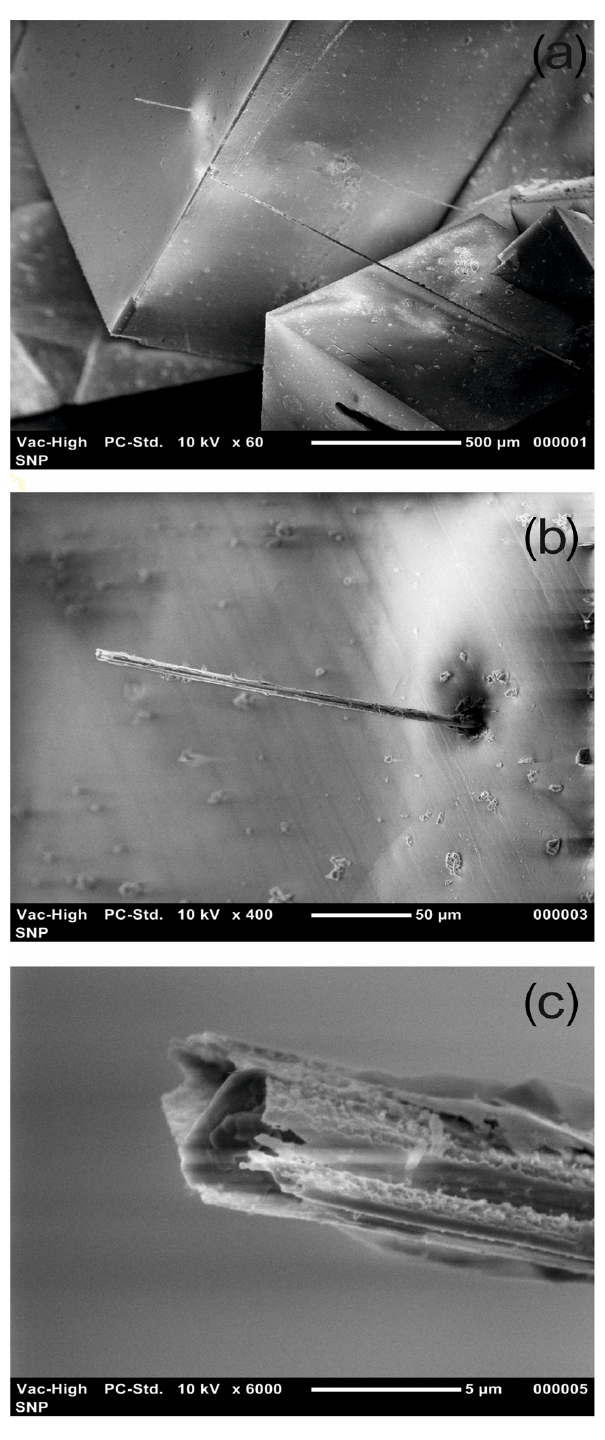
Figure 1. Scanning Electron Microscope (SEM) images of luxem- bourgite fibres occurring on rhombohedral dolomite crystals.